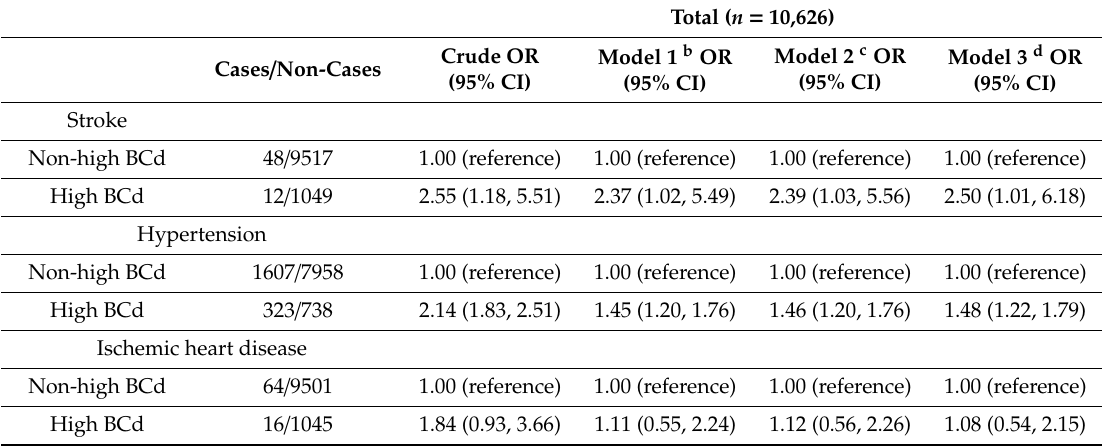
Table 3. Odds ratios (95% CIs) of cardiovascular diseases associated with high BCd level a . Total ( n = 10,626)